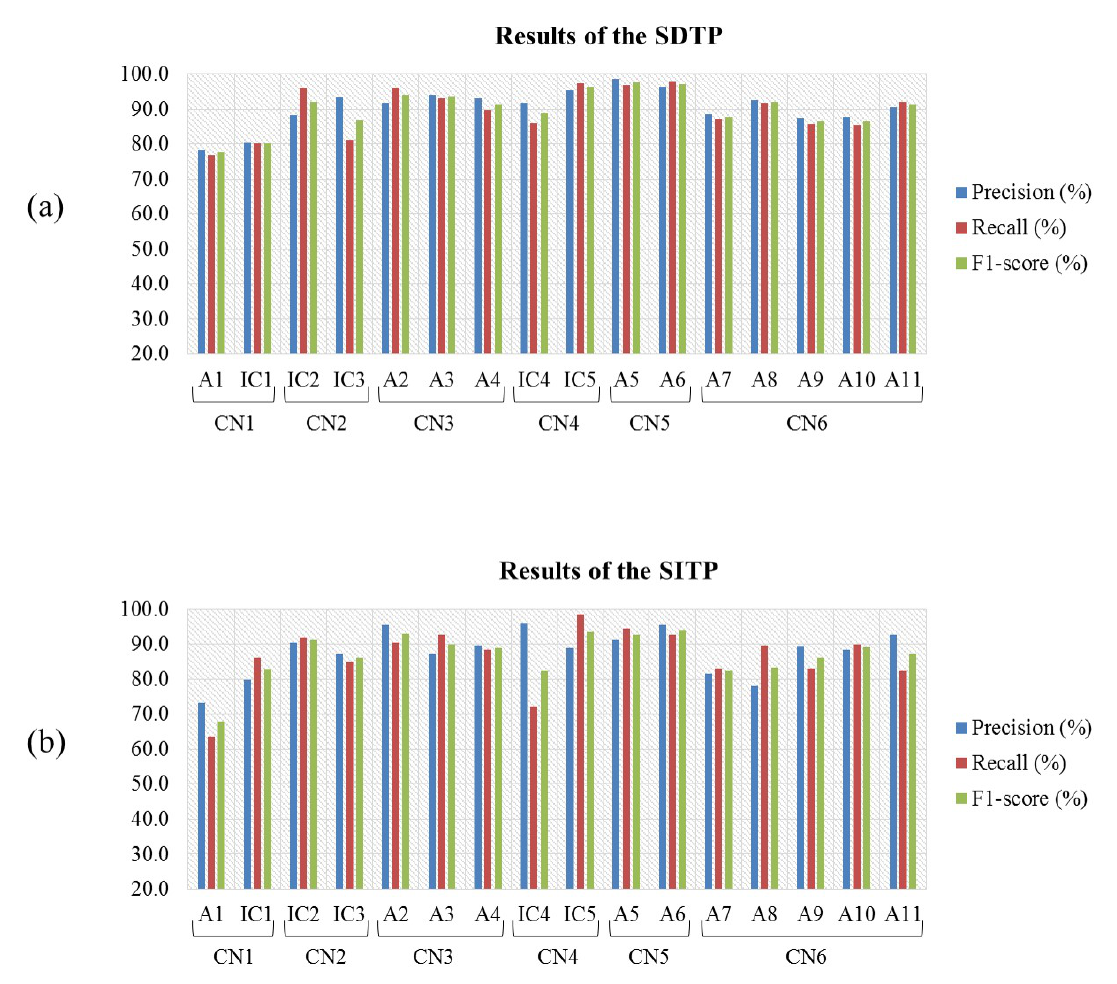
Figure 7. Average PRC, RCL, F 1 -score values of each of the eleven HMITs and the five intermediate classes for the amputated subjects obtained based on the TFF of C 1 using ( a ) SDTP and ( b )